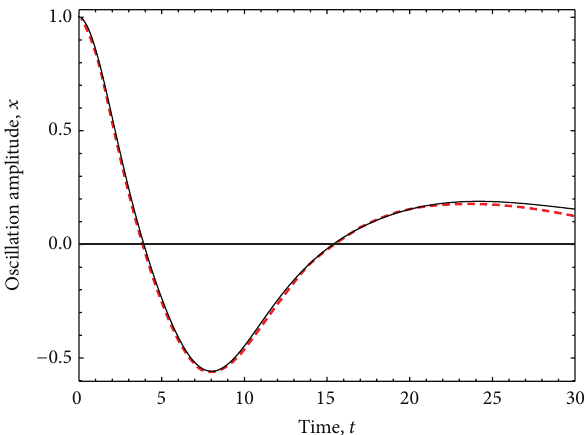
Figure 3: Amplitude-time response curves of (22) and (24). Here, the solid line represents the numerical integration solution of (18), while the dashed line represents the prediction obtained by using thederivedequivalentequationofmotionbyapplyingourenhanced cubication procedure. The parameter values are 𝐷 = 1 , 𝜆 1 = 1 , 𝜆 2 = = 1 and ̇𝑦(0) = 0 −1 , and ] = 0.1 with 𝑦 10